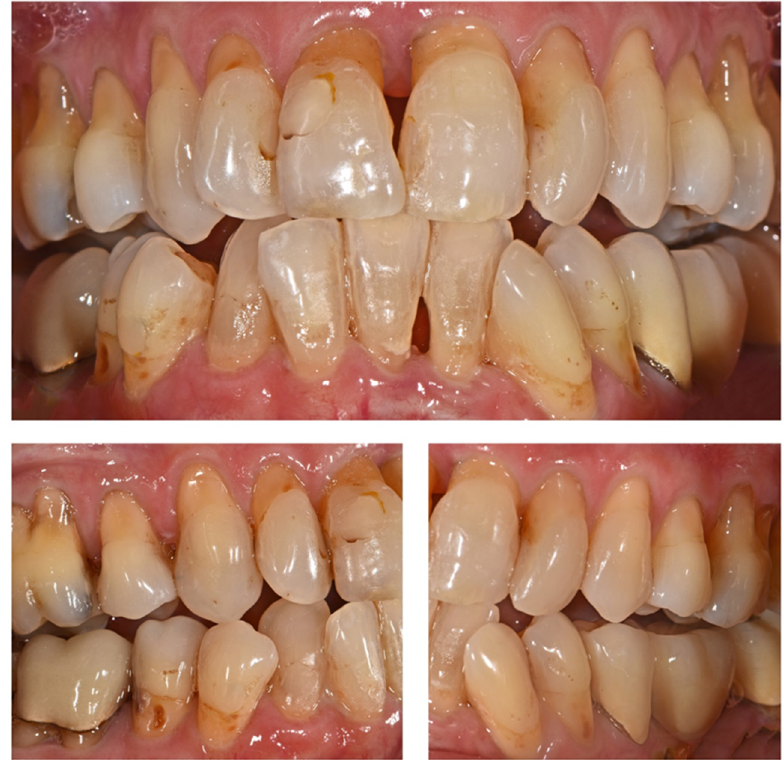
Figure 1. Clinical example of a 65-year-old female patient with a periodontally compromised dentition.